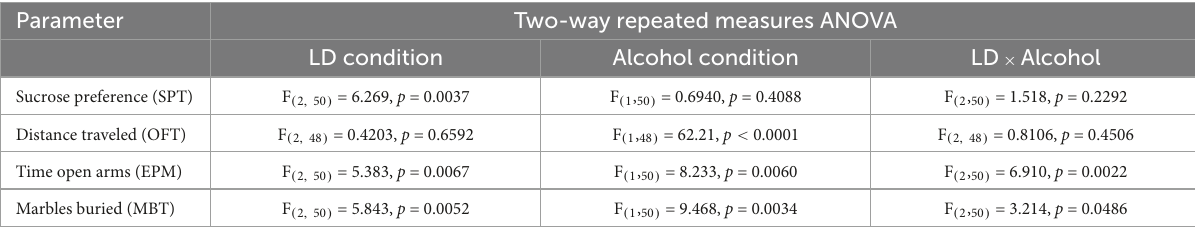
TABLE 3 Statistical results of behavioral